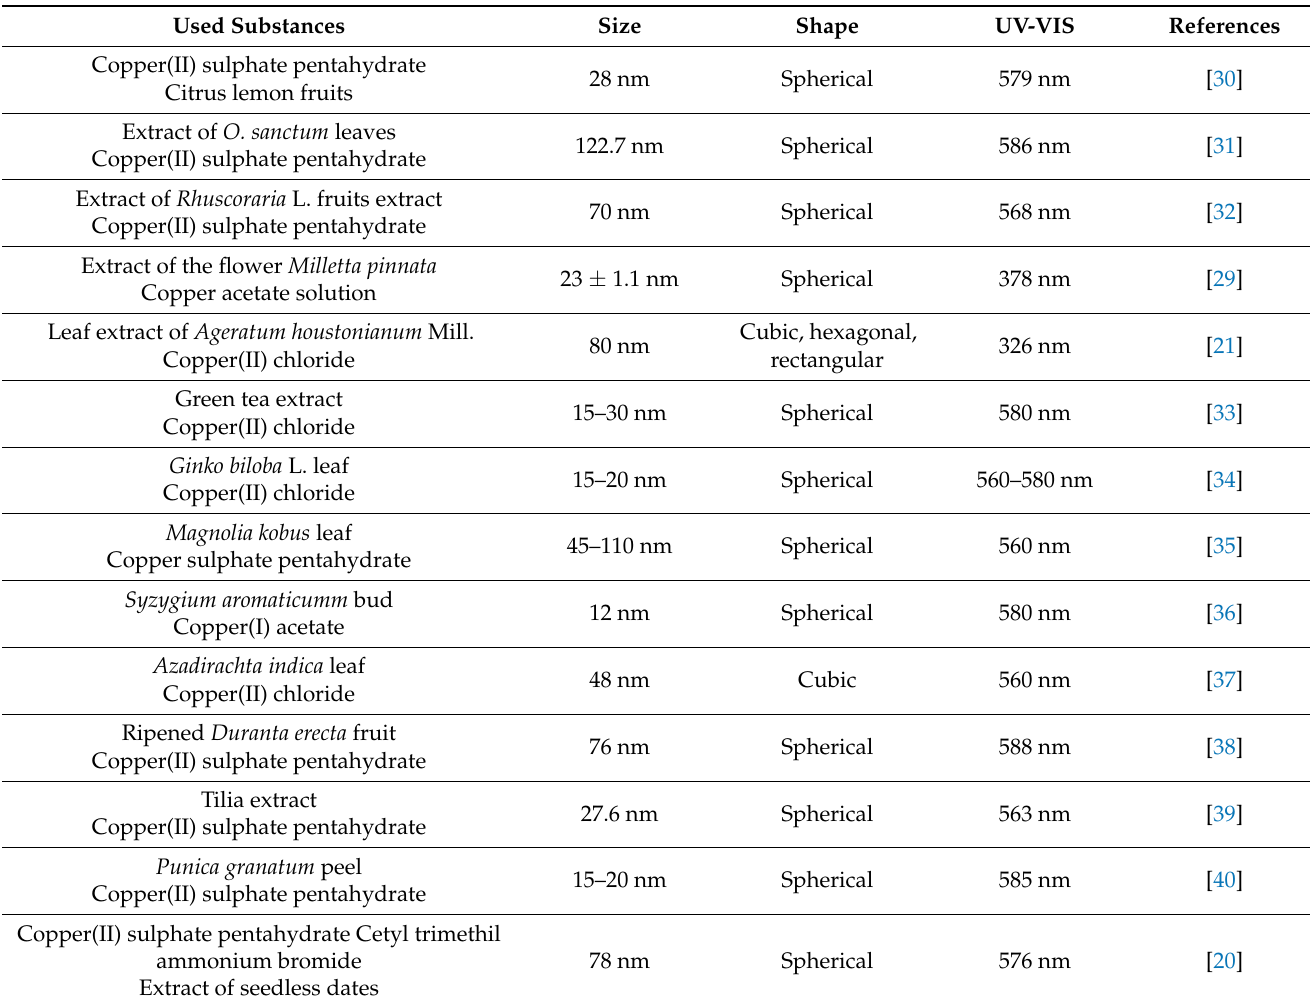
Table 3. Green synthesis methods of copper